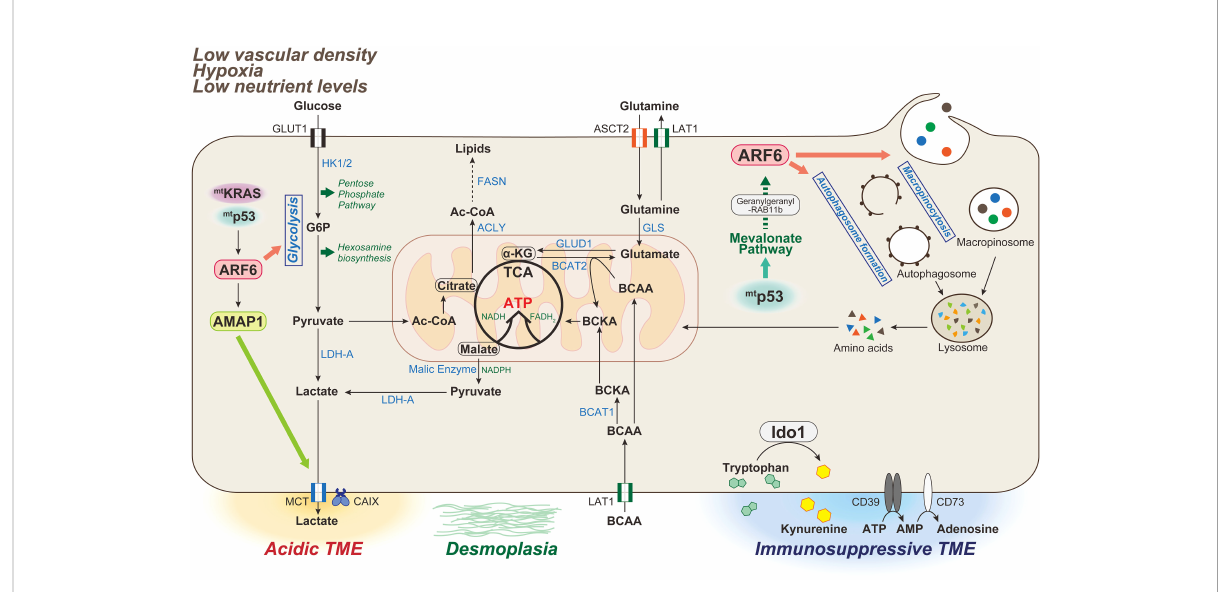
FIGURE 2 Metabolic characteristics of PDAC associated with the ARF6-based pathway. The tumor microenvironment (TME) in PDAC is characterized by low vascular density, resulting in severe hypoxia and low nutrient levels. PDAC is also characterized by a dense desmoplastic stroma. In mammals, glucose and glutamine are two of the most abundant nutrients that support cell survival and growth. Oncogenic KRAS mutations induce metabolic reprogramming by triggering the uptake of glucose, leading to increased glycolytic fl ux, carbon donation to the pentose phosphate pathway and hexosamine biosynthetic pathway, and lactate production driving acidic TME. Glutamine is also used as an energy substrate in the TCA cycle, and maintains the intracellular redox state of PDAC cells in an oncogenic KRAS- driven manner. Double mutations of KRAS / p53 cooperatively promote the expression and activation of the ARF6-AMAP1 pathway, and ARF6 is involved in maintaining the Warburg effect to meet the abnormal nutritional and energy demands of PDAC cells, as well as those required for autophogosome and macropinosome formation. Mutant p53 promotes ARF6 activation via the enhanced expression of mevalonate pathway enzymes, and also intracellular traf fi cking of ARF6 mediated by geranylgeranylation of RAB11b. TCA, tricarboxylic acid; HK-1/2, hexokinase-1/2; G6P, glucose 6-phosphate; LDH-A, lactate dehydrogenase-A; MCT, monocarboxylate transporter; CA, carbonic anhydrase; Ac-CoA, Acetyl-CoA; ACLY, ATP-citrate lyase; FASN, fatty acid synthase; GLS, glutaminase; GLUD, glutamine dehydrogenase; BCAA, branched-chain amino acid; BCAT, branched-chain amino acid transaminase 1; IDO, indoleamine